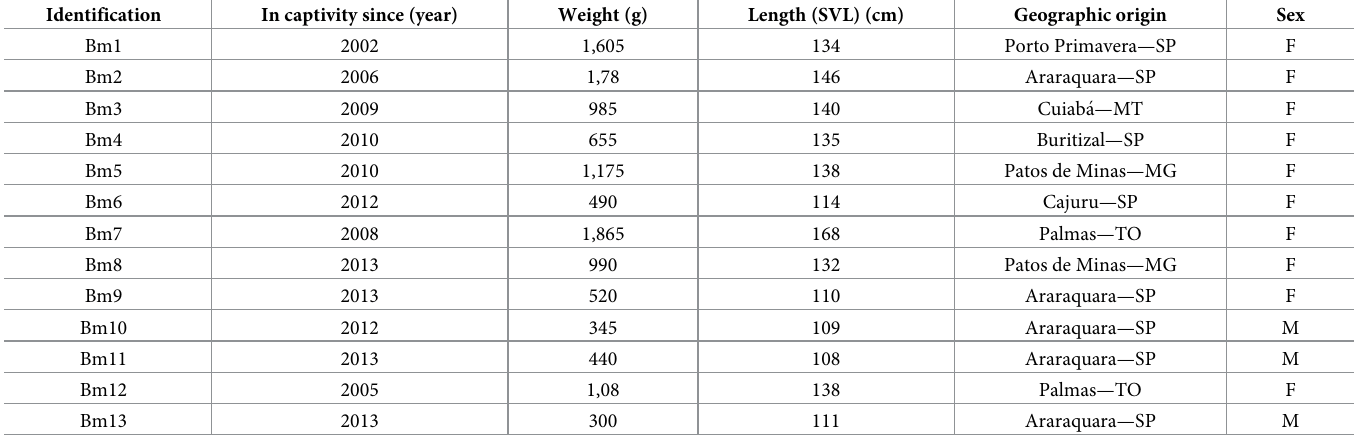
Table 1. Biometric data and geographical origin of the Bothrops moojeni specimens used throughout this study. Individuals were identified after venom and plasma extractions. Identification: code used in this study to identify the individual; In captivity since (year): year when the individual came from nature to captivity; Weight (g): weight of each individual when samples were collected; Length (SVL) (cm): length of the individuals when samples were collected. SVL means snout-vent-length ; Geo- graphical origin: the place where the individual came from; Sex: M: male; F: female.